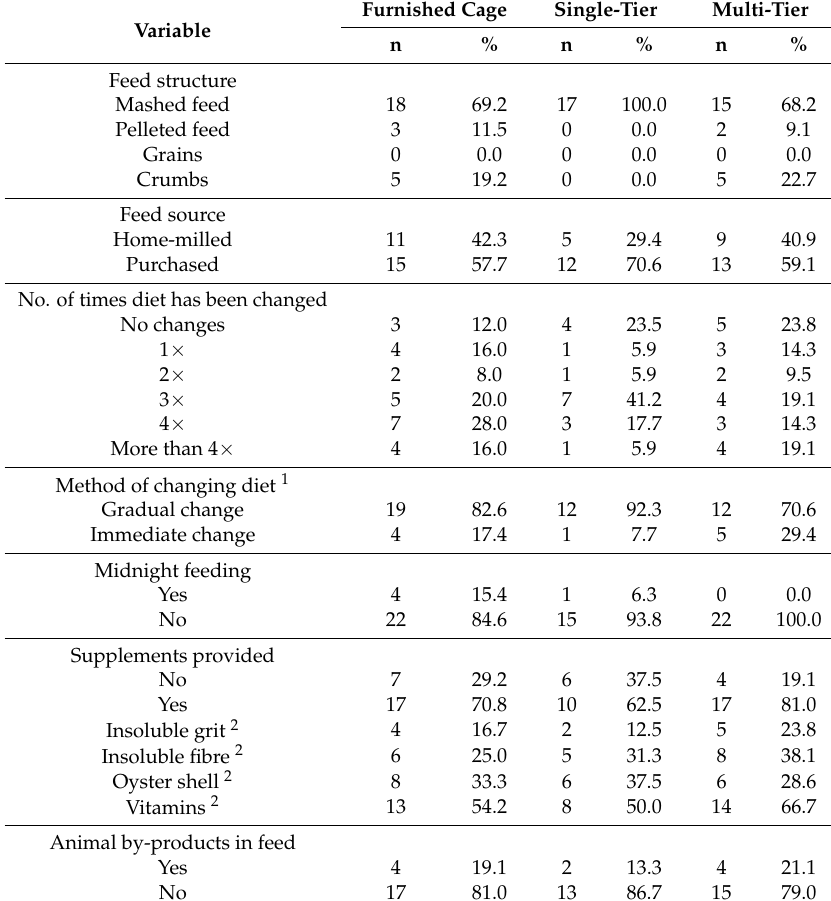
Table 4. Frequency of nutrition and feeding practices for 65 laying hen flocks placed between October 2016 and December 2017 according to housing system (furnished cage n = 26, single-tier n = 17, multi-tier n = 22) in